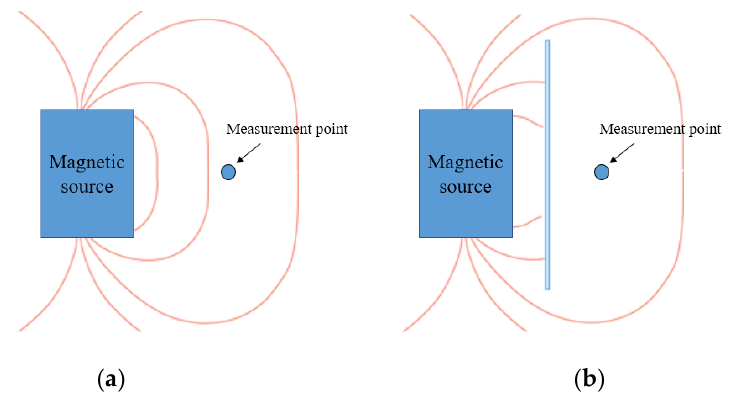
Figure 11. Results of the second design: ( a ) magnetic flux leakage; ( b ) displacement; ( c ) impedance.